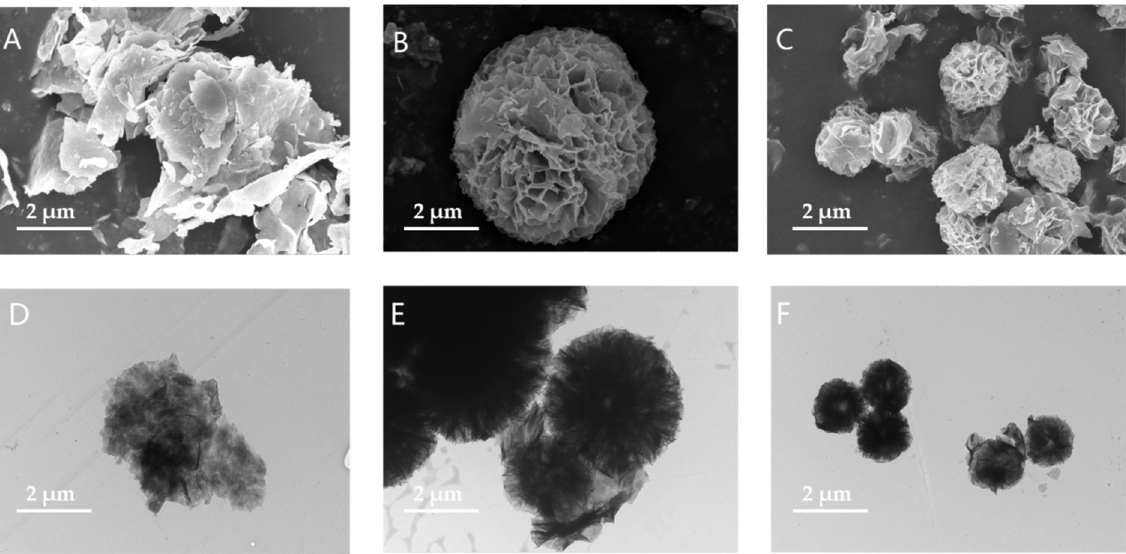
Figure 1. SEM images of ( A ) Cu 3 (PO 4 ) 2 ·3H 2 O; ( B ) ACHNs; and ( C ) DCHNs. TEM images of ( D ) Cu 3 (PO 4 ) 2 ·3H 2 O; ( E ) ACHNs; and ( F ) DCHNs.